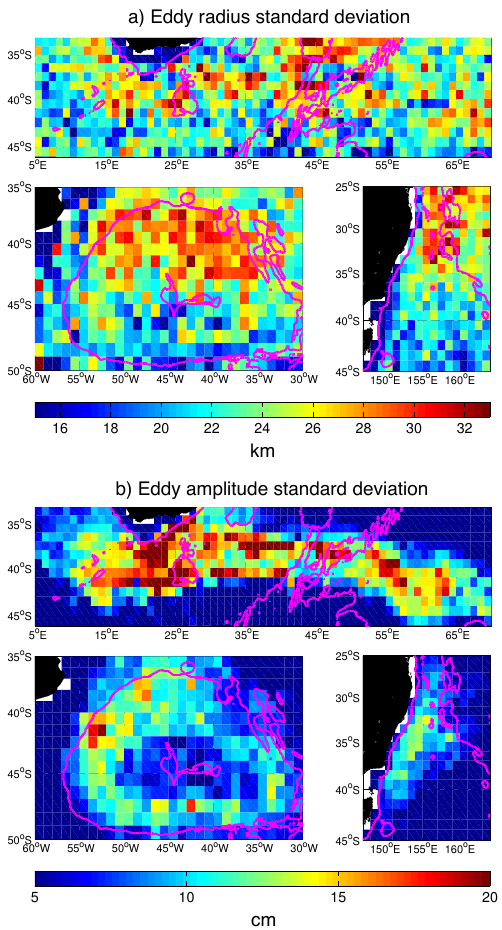
Figure 4. Standard deviation of (a) radii (km) and (b) amplitude (cm) of eddy-like features (lifetime >4 weeks) in the AC, BC and EAC systems in a 1 ◦ × 1 ◦ grid, with magenta lines indicating the 4000, 3000 and 2000m isobaths,